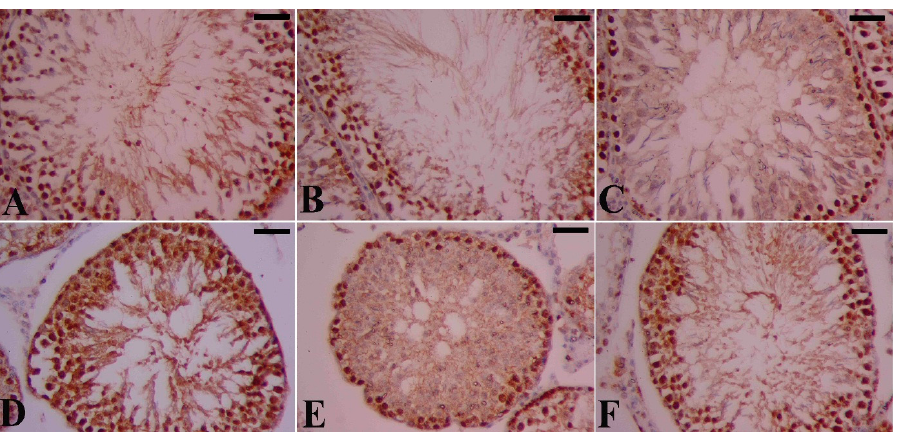
Figure 8. PCNA staining of the testis of STZ-diabetic rats. Spermatogenic cells from the rat testis were stained with a specific antibody against PCNA. ( A ) control rats; showing the typical presence of spermatogenic cells in the seminiferous tubules; ( B ) SeNPs-treated rats; showing an abundance of spermatogenic cells in the seminiferous tubules; ( C ) STZ-diabetic rats, showing weaker PCNA-immunoreactivity and fewer spermatogenic cells in the seminiferous tubules compared to A and B; ( D ) STZ-SeNPs-treated rats: a stronger PCNA-immunoreactivity with an increased number of spermatogenic cells in the seminiferous tubules was observed compared to C; ( E ) STZ-Ins-treated rats, fewer positive nuclei for PCNA in the spermatogenic epithelium cell were observed; and ( F ) STZ-SeNPs-Ins-treated rats, a marked elevation in the expression of PCNA was seen, as indicated by the increased PCNA-immunoreactivity compared to C and E. Scale bar = 50 μ m.